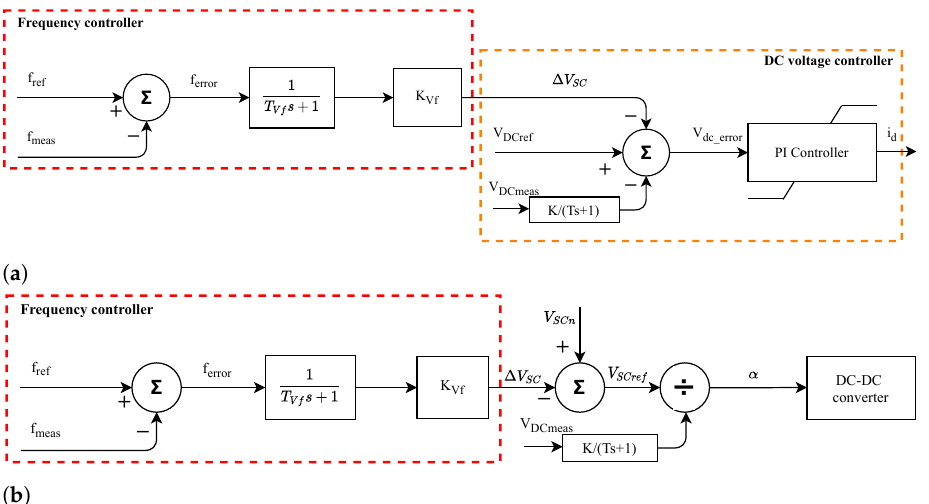
Figure 5. SC controllers. ( a ) Controller for directly-connected SC. ( b ) Controller for converter- connected